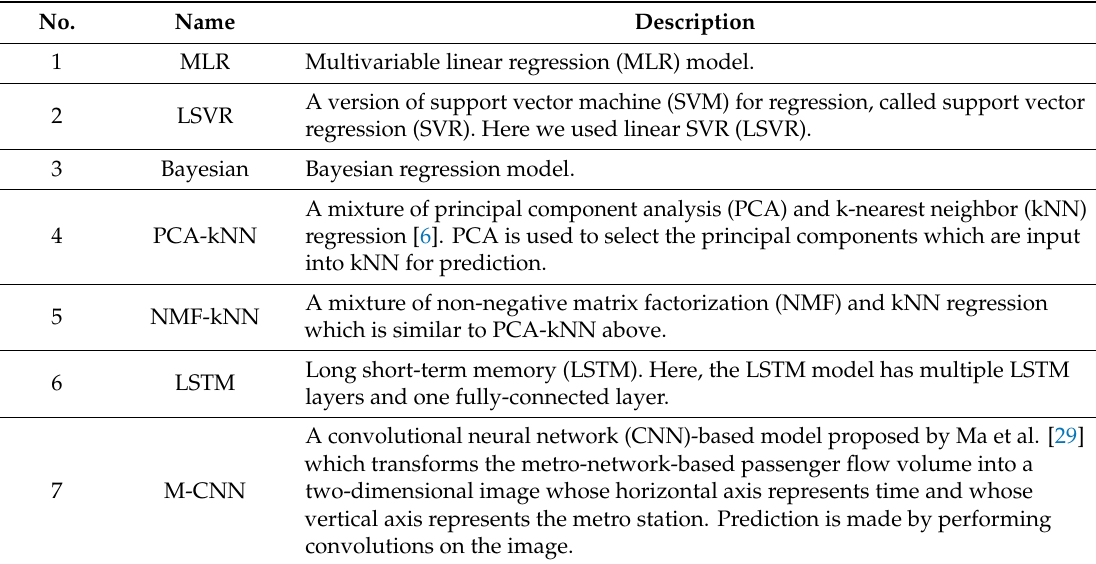
Table 1. Brief introductions to the baselines models used for comparison with the model used in this